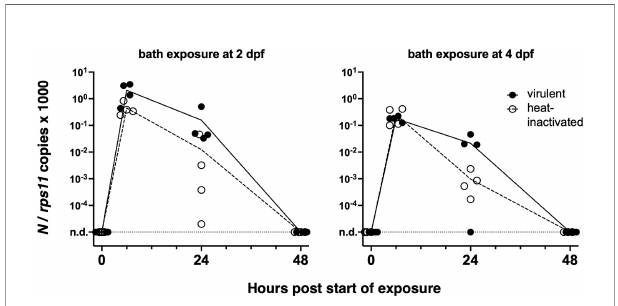
FIGURE 1 | Bath exposure of zebra fi sh larvae to SARS-CoV-2. Kinetics of qRT-PCR measurements of polyadenylated viral N copies; each point corresponds to an individual larva. n.d.,